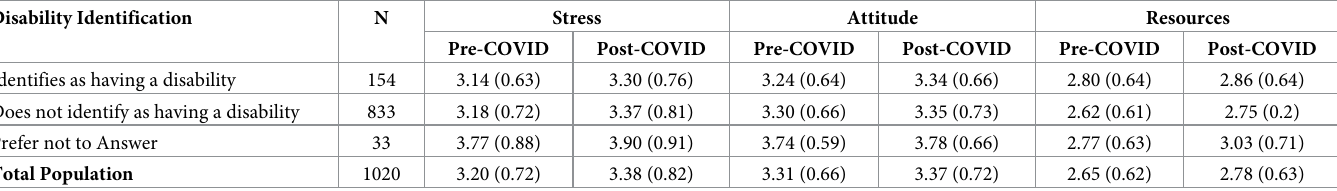
Values represent mean score with standard deviation in